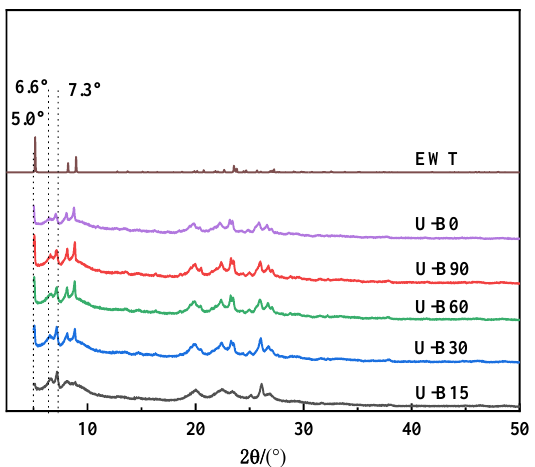
Figure 2. The XRD pattern of samples with different n (SiO 2 )/ n (B 2 O 3 ) ratios.